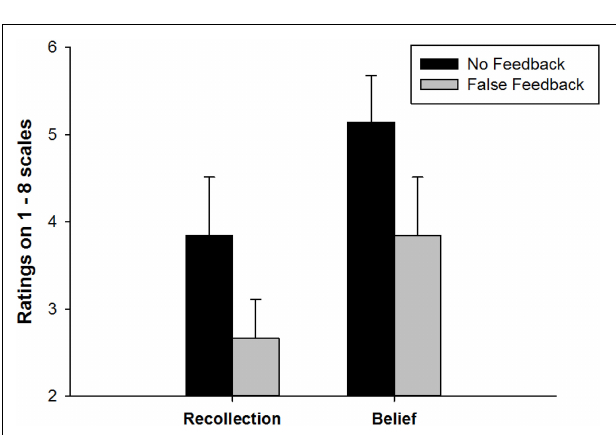
FIGURE 2 | Recollection and belief ratings in False feedback and No feedback conditions. Error bars represent